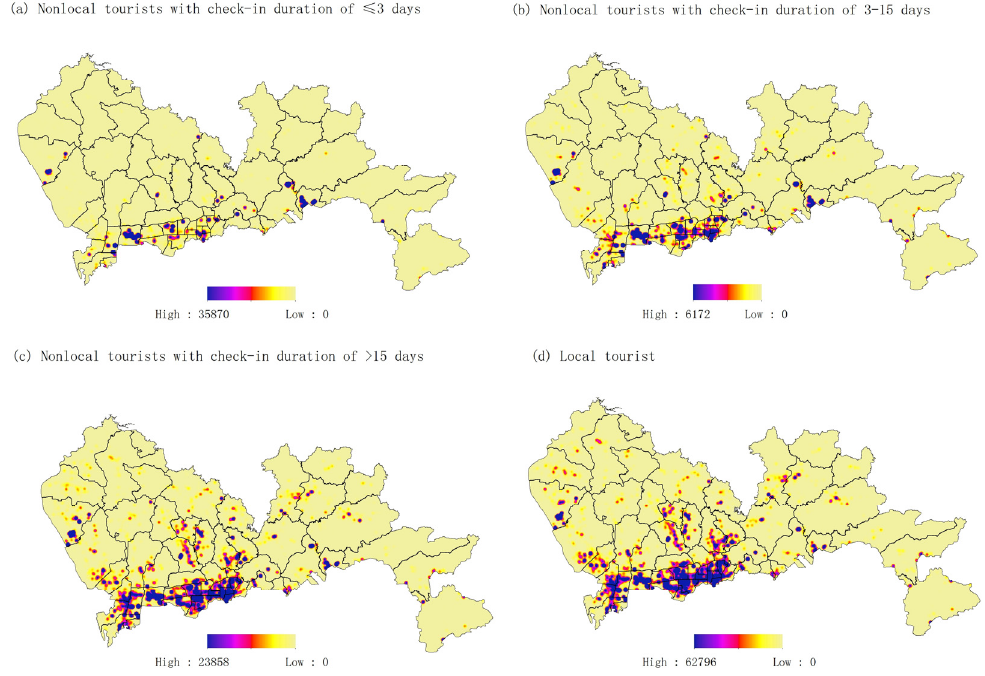
Figure 5. Activity kernel density of different users.